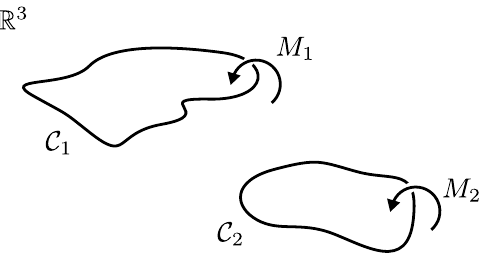
Figure 1 . A non-Abelian con(cid:12)guration of two supertubes. The monodromy matrices M 1 ; M 2 of the two supertubes do not commute, [ M 1 ; M 2 ] 6 =